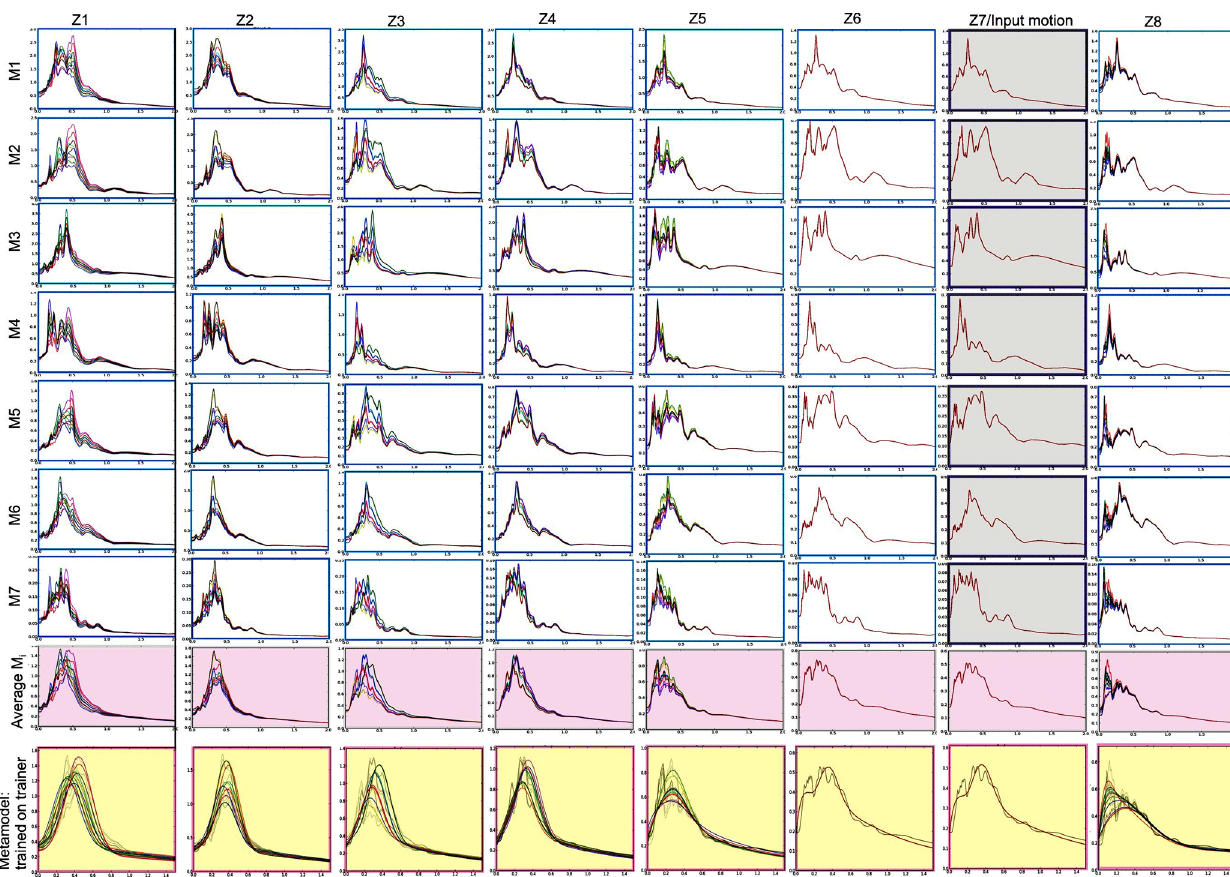
Figure 8. Example of meta-model processing for the SRS using seven input motions having average spectrum matched on an unamplified design spectrum. This last corresponding to the average spectrum of the zone Z7 where the rigid rock